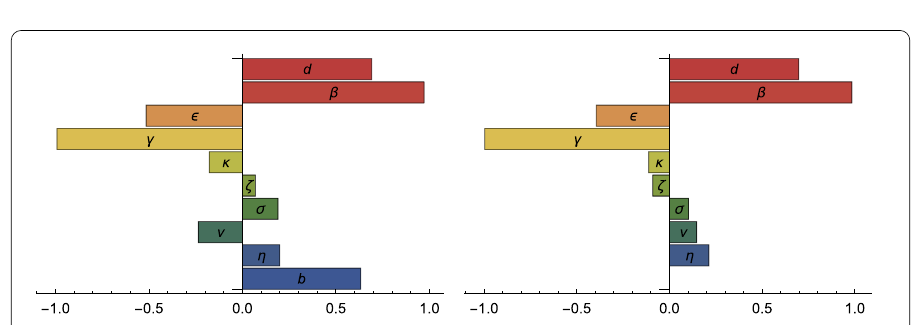
Figure 4 Maximal PRCC values ( t ∈ [0,5]) of new varicella patients at the seasonal (left) and autonomous (right)